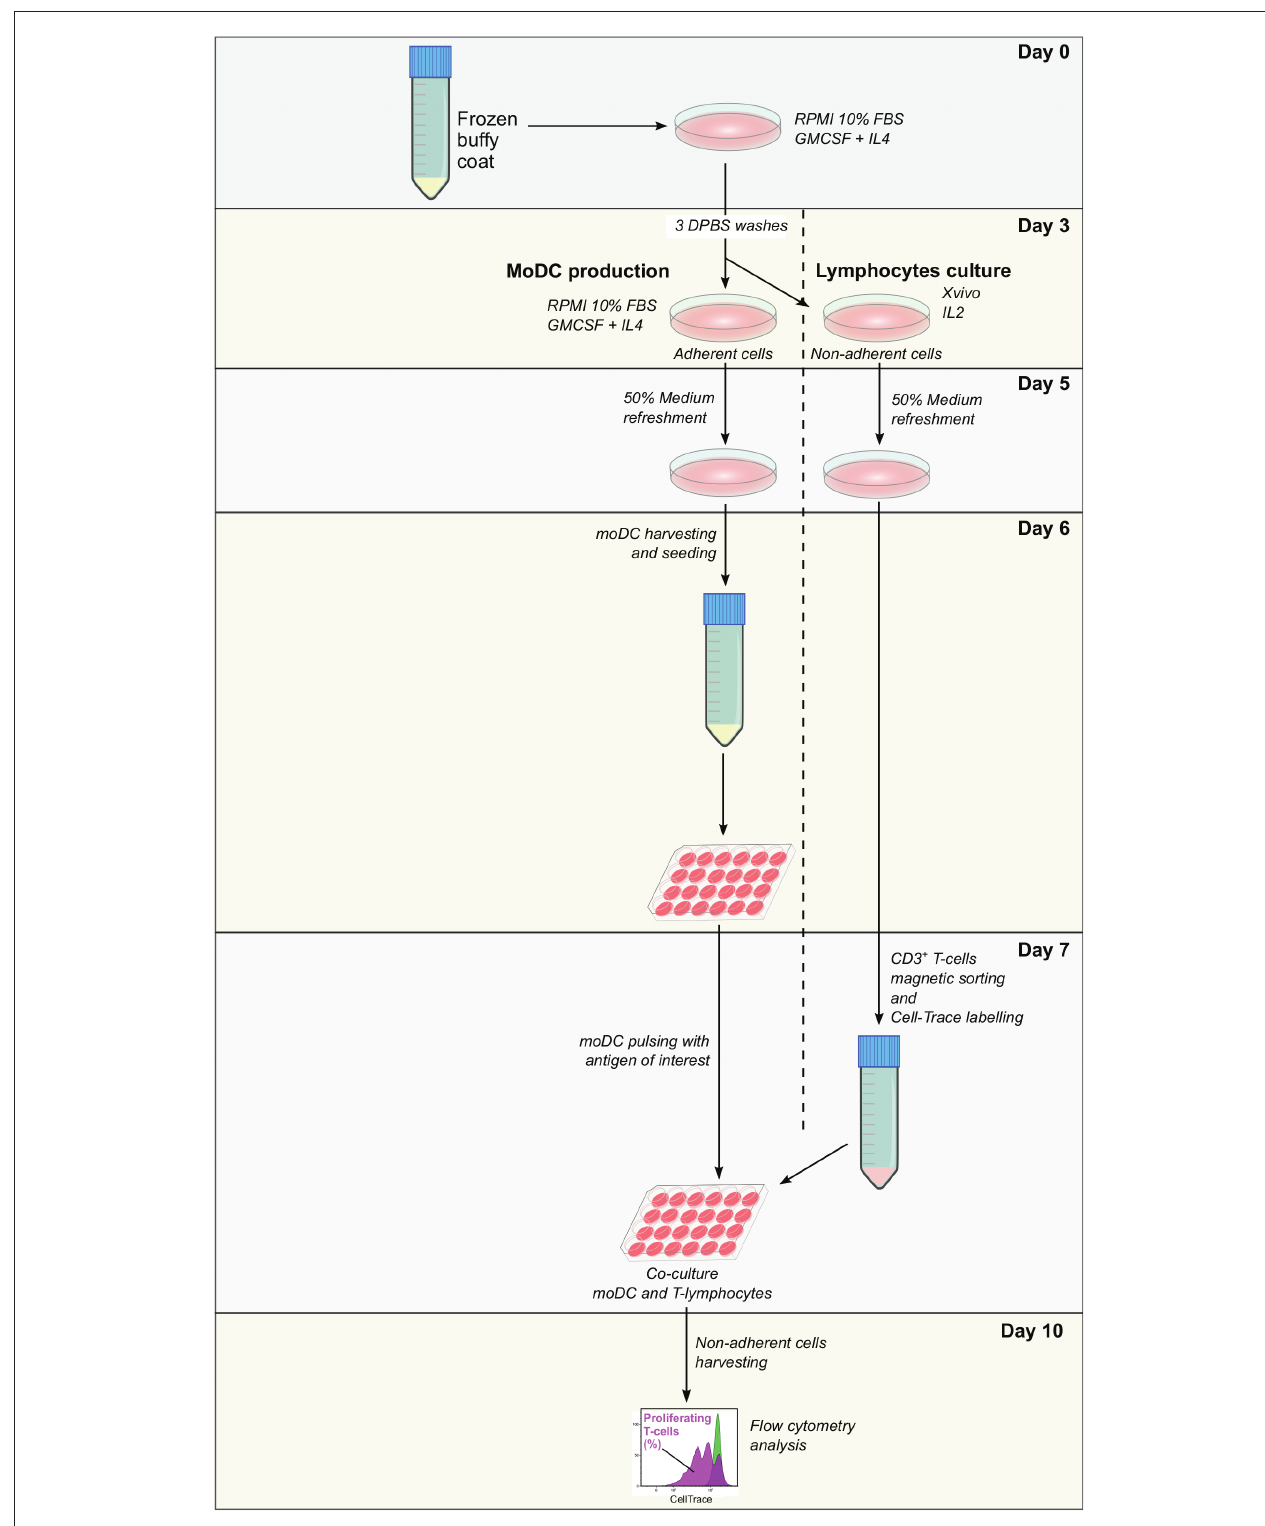
FIGURE 3 | Antigen presentation assay using a single frozen sample. Frozen PBMC are thawed and incubated in RPMI 10% fetal bovine serum (FBS) supplemented with granulocyte-macrophage colony-stimulating factor (GM-CSF) and interleukin-4 (IL-4). After 3 days, non-adherent cells are removed and used for the expansion of lymphocytes, while adherent cells are used for the derivation of moDC according to the simplified protocol 1. At day 7, moDC is pulsed with the antigen of interest and CD3 + T cells are sorted from expanded lymphocytes. Pulsed moDC and CellTrace-labeled lymphocytes are co-cultured and after 3 days, non-adherent cells are collected and analyzed by flow cytometry. The levels of antigen presentation are estimated based on the percentage of proliferating T cells.